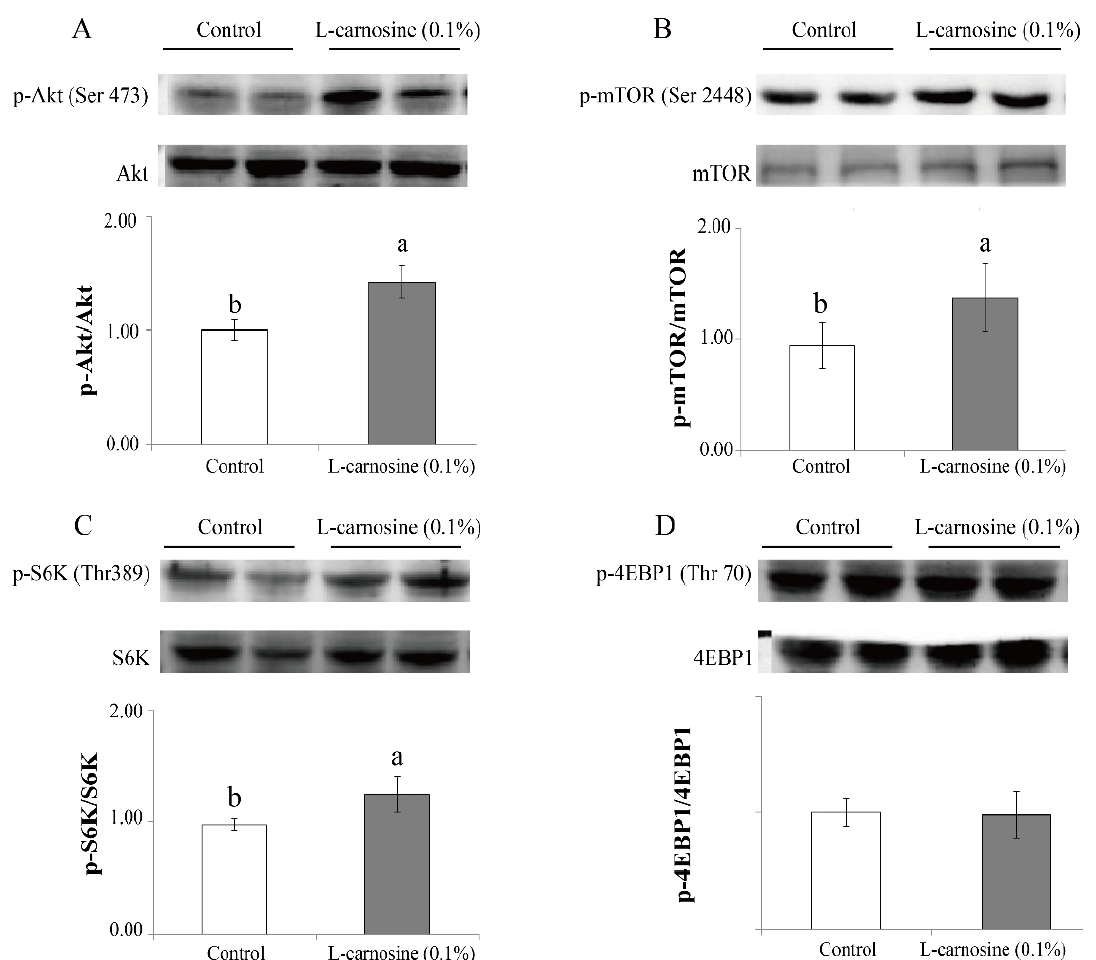
Figure 1. Effect of carnosine on expression of the mTOR pathway in the longissimus dorsi muscle of finishing pigs. Values of Akt ( A ), mTOR ( B ), S6K ( C ), and 4EBP1 ( D ) are presented as phosphorylation concentrations in relation to the total concentration. Control: diet without L-carnosine; L-carnosine (0.1%): diet supplemented with 0.1% L-carnosine. p-, phosphorylation; Ser, serine; Thr, threonine; Akt, protein kinase B; mTOR, mechanistic target of rapamycin; S6K, ribosomal protein S6 kinase; 4EBP1, 4E binding protein 1. Data are expressed as mean values ± SD. Means with different superscript letters (a,b) indicate significant differences at p < 0.05.